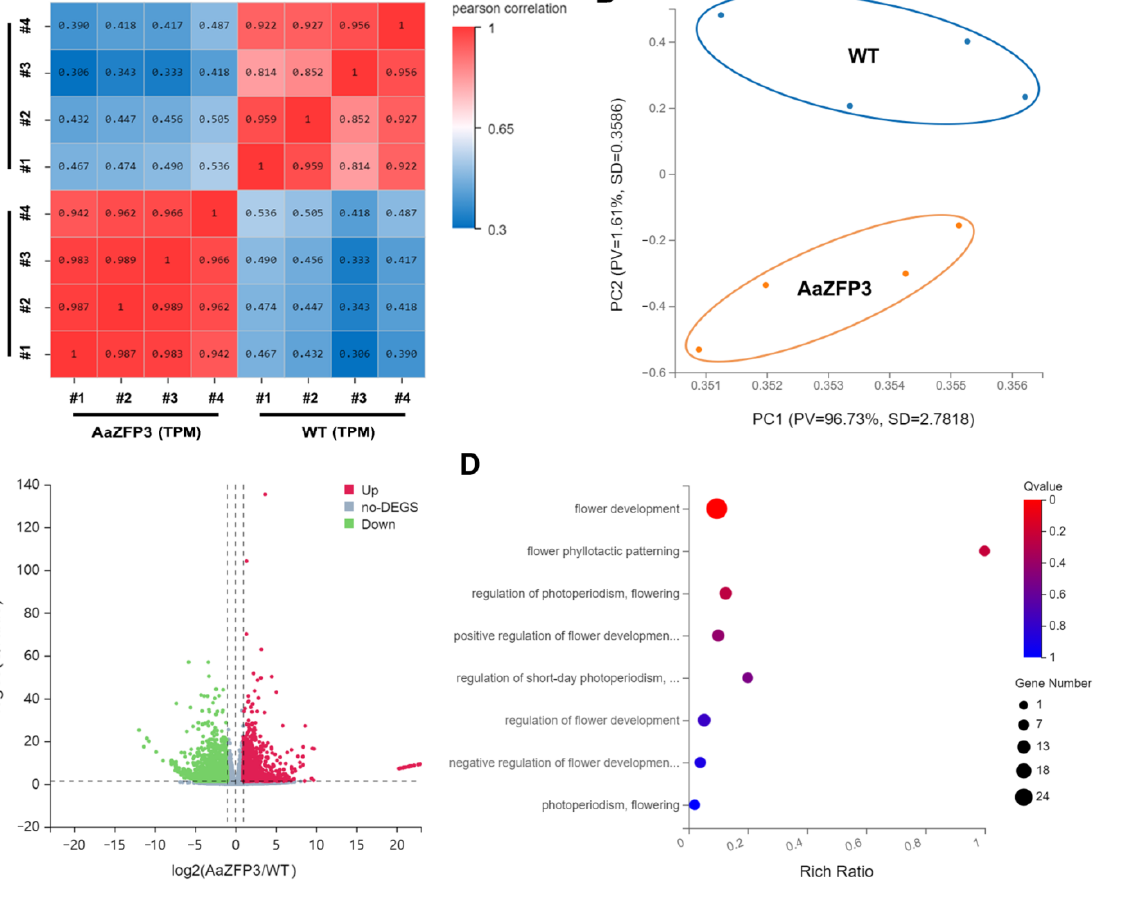
Figure 5. RNA-sequencing analysis of differentially expressed genes (DEGs) between wild-type (WT) and transgenic Arabidopsis plants overexpressing AaZFP3 . ( A ) Correlation matrix heatmap showing pairwise Pearson correlation coefficients, represented by the color scale. ( B ) Principal component analysis (PCA) of gene expression from eight RNA-seq samples. ( C ) Volcano plot showing the number of DEGs in AaZFP3 -overexpressing transgenic versus WT Arabidopsis plants. The abundance of each gene was normalized as transcripts per million (TPM). We used a false discovery rate ≤ 0.05 and an absolute value of log2Ratio ≥ 2 as the threshold for significance. Red, up-regulated; blue, down-regulated; gray, no significant change (no-DEGs). ( D ) GO term enrichment analysis of all DEGs involved in flowering regulation-related GO terms. The rich ratio is the ratio of the number of DEGs annotated under a given GO term to the total number of genes annotated under the GO term. The q -value is the corrected p -value and ranges from 0 to 1 as represented by the color scale. The size of the dot indicates the number of genes contributing to the GO term.